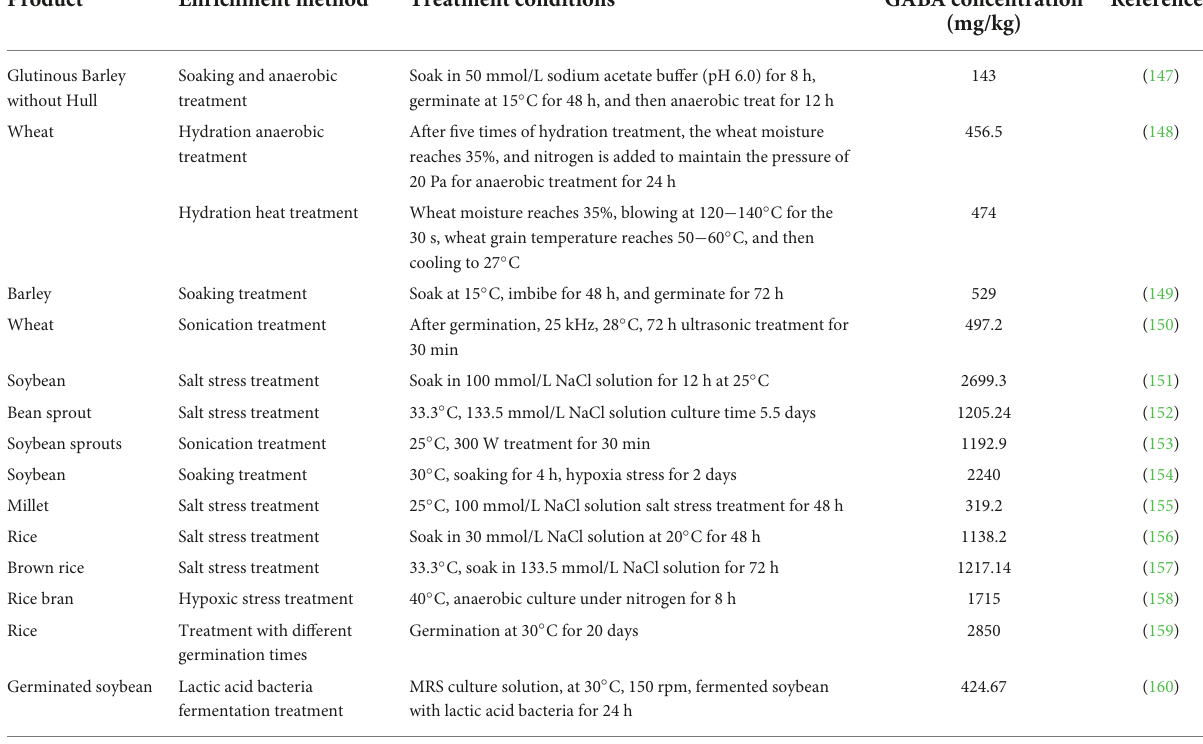
TABLE 3 Different GABA enrichment approaches in plants.